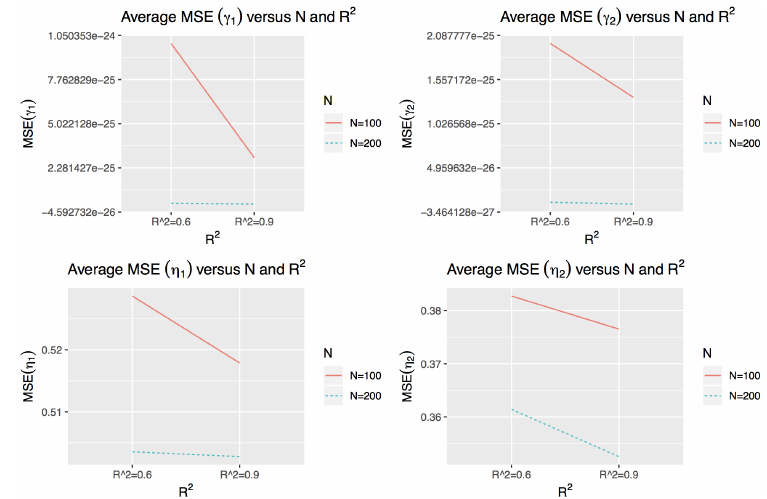
Figure 2. Average MSE of functional coefficients versus simulation cases (2-D plot).